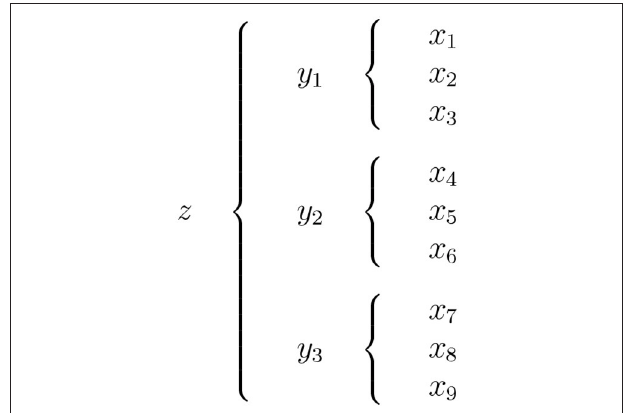
FIGURE 1 | Borges’ schematic of Quain’s novel April March . The reader can choose among nine different paths.